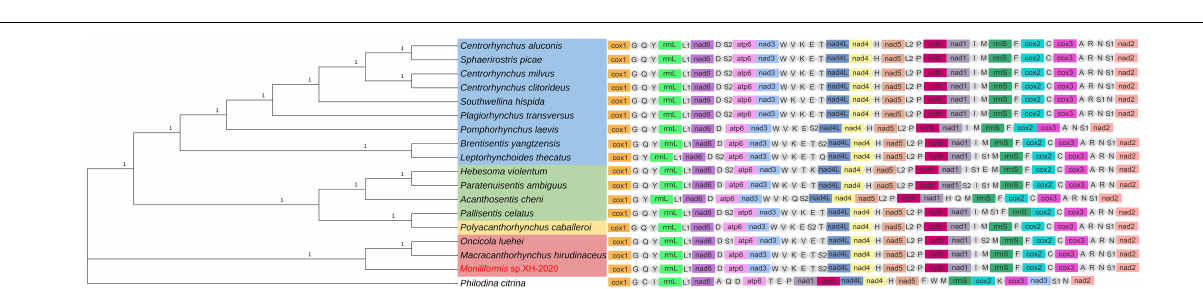
FIGURE 5 | Molecular evolutionary analysis of acanthocephalans based on 18S rDNA gene by Bayesian inference. Node values are Bayesian posterior probabilities (BPP), the red color indicates the class Archiacanthocephala, the green color indicates the class Eoacanthocephala, the blue color indicates the class Palaeacanthocephala and the yellow color indicates the class Polyacanthocephala.